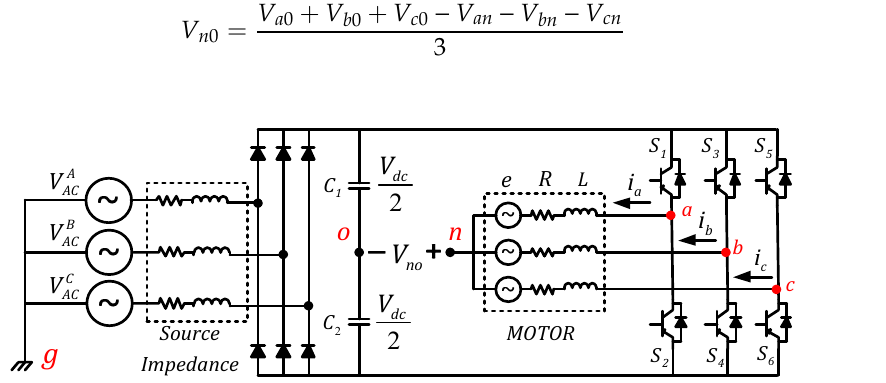
Figure 2. PWM inverter-controlled induction machine.